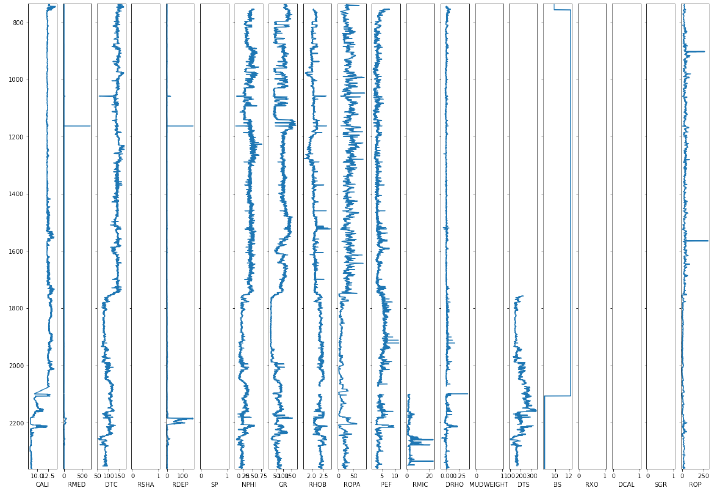
Figure 5. Real value of logs with missing